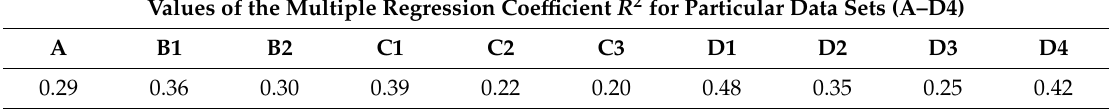
Table 3. Values of determination coe ffi cient ( R 2 ) of multiple regression models for particular data sets (A–D4) obtained during preliminary grouping of observations in respect of content of particles < 0.02 mm for dependence of penetration resistance ( PR ) on gravimetric moisture content and dry bulk